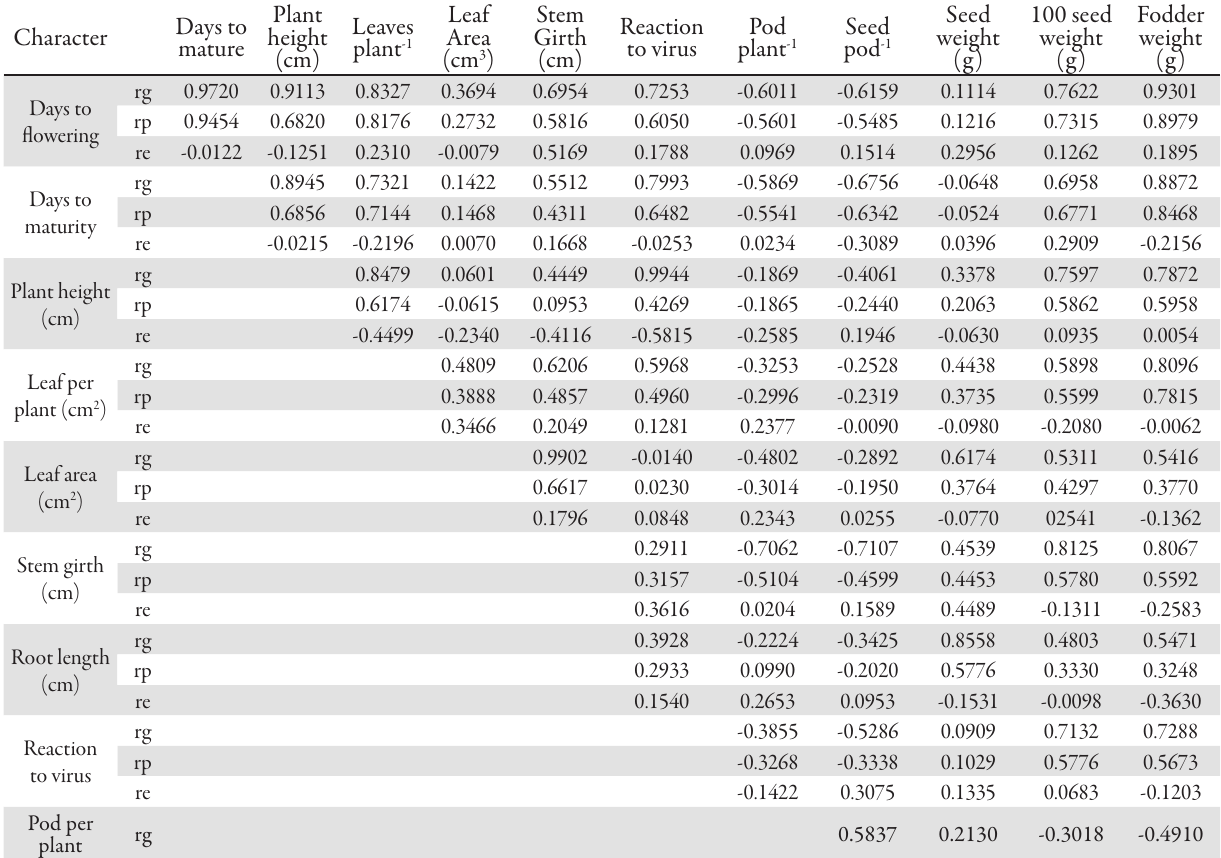
Tab. 2. Genotypic, phenotypic and environmental correlation coefficients for growth and yield components in 2004 wet